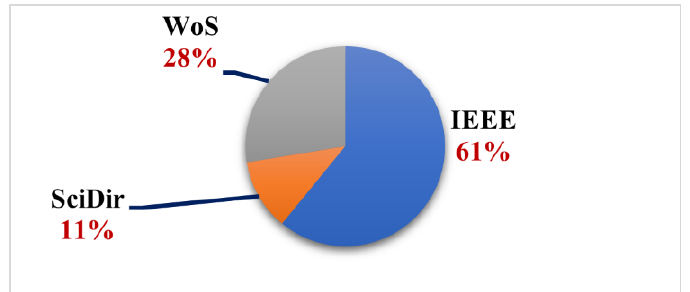
Figure 1. Number of final sets of articles per database engine.